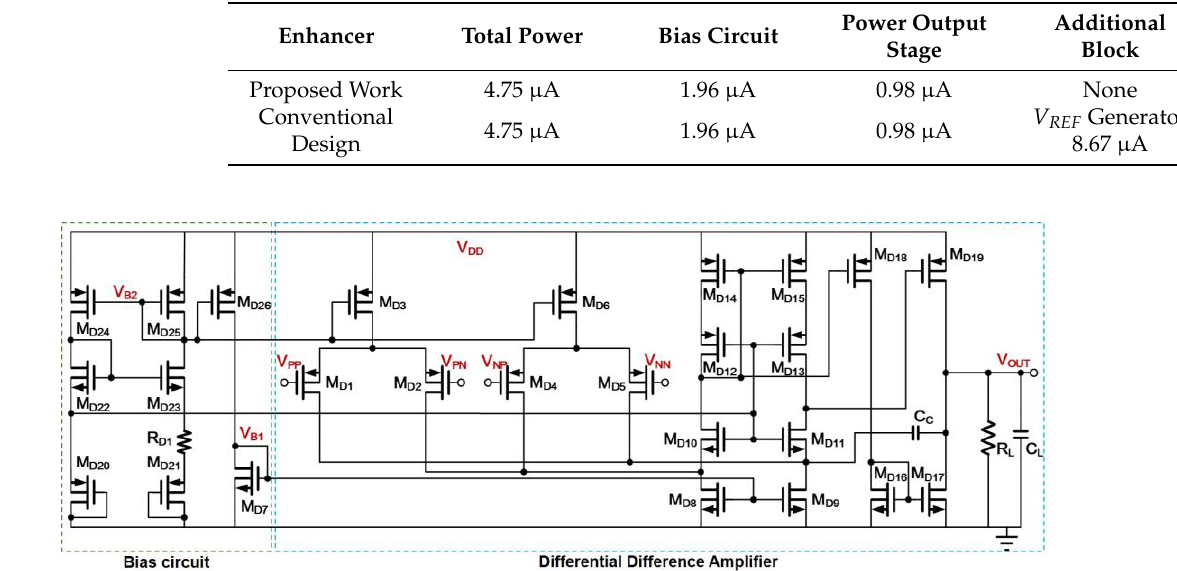
Table 4. Performance summary of the DDA. Supply Voltage